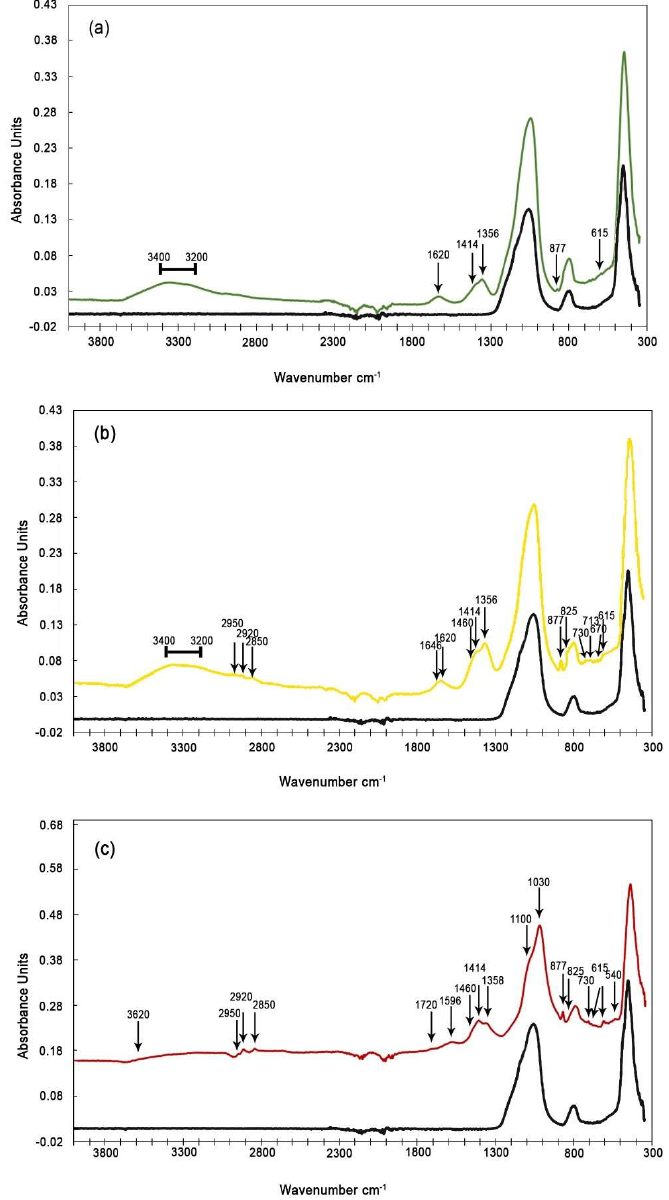
Figure 3. FTIR spectra of ( a ) suburban PM 10 filter (BF station); ( b ) urban PM 10 filter (GC station); and ( c ) urban PM 2.5 filter (DB station). For each spectrum, we also report the spectrum of a blank quartz filter (black line) for comparison. Some peaks have no well-defined forms, and the presence of a shoulder indicates that there are overlapping peaks due to several different types of molecules absorbing IR radiation within the same